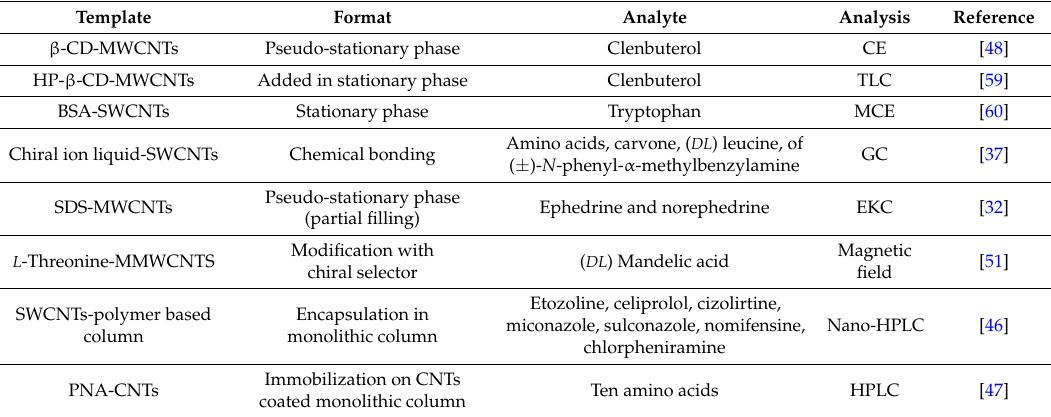
Table 1. Different approaches for the enantioseparation with